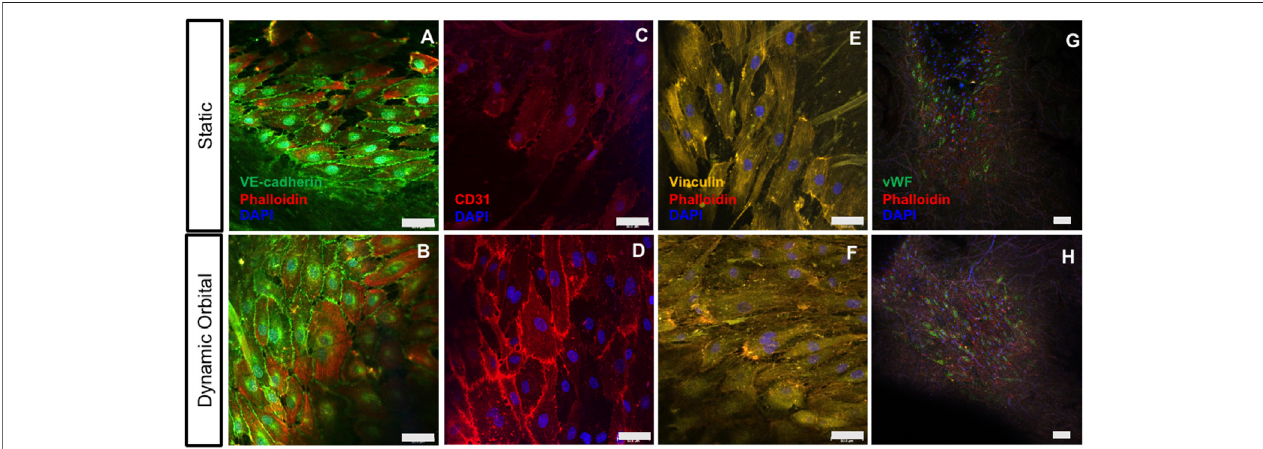
FIGURE3| ECFCsculturedonhTEMsexpresscharacteristicECmarkersafter14 days. (A – B) :ECFCsstainedforVE-CAD(green),Phalloidin(red),andDAPI(blue) showcon fl uentendothelializationandexpressionofcell-cellsurfacemarkersunderbothstaticanddynamicorbitalconditions. (C – D) :ECFCsstainedforCD31(red)and DAPI (blue) show the expression of ECFCs intercellular junctions under static and dynamic fl ow conditions. (E – I) : Staining for Vinculin (yellow), Phalloidin (red) and DAPI (blue) demonstrating the expression of focal adhesions by ECFCs. (G – H) : Staining for vWF (green), Phalloidin (red), and DAPI (blue) demonstrate endothelium functionality (50 µm scale bars).